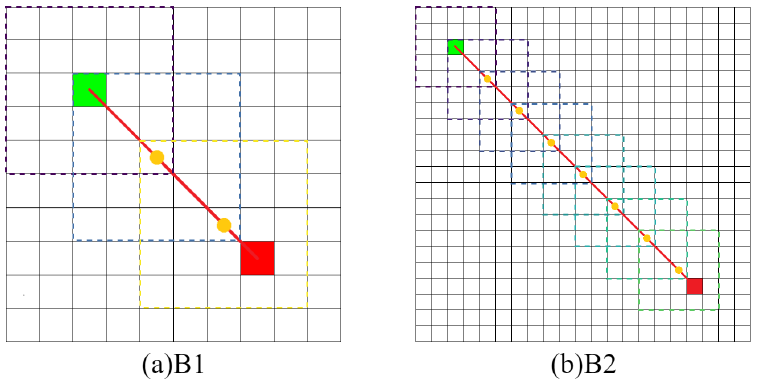
Figure 12. Local environment information of obstacle-free